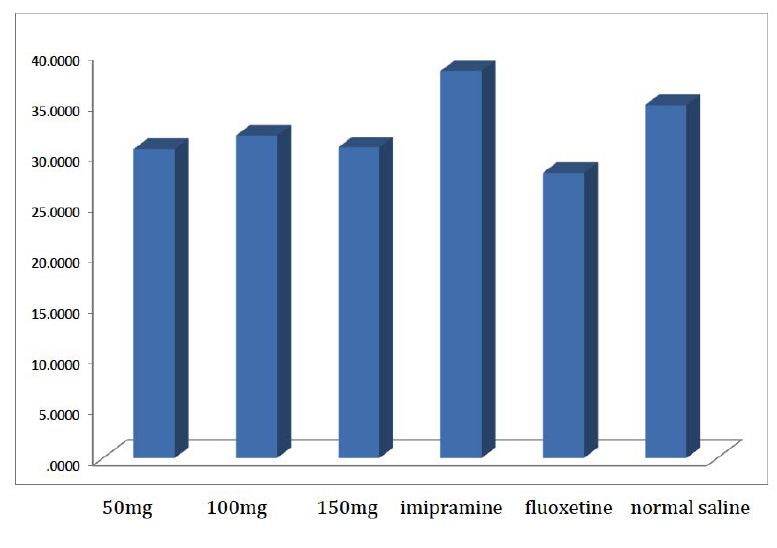
Figure 1. Effect of aqueous extract of plant (50, 100, 150 mg/kg) Lavandulifolia Stachys , imipramine, fluoxetine, normal saline on climbing. Data represents the mean activity counts per 5 min. Comparisons were made using one-way ANOVA. P<0.01.